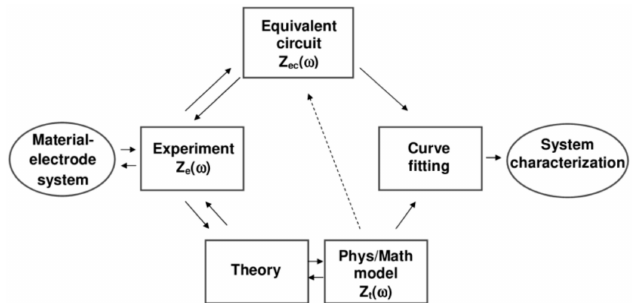
Figure 3. A scheme showing the use of electrochemical impedance spectroscopy (EIS) to investigate characteristics of a material–electrode interface. Reprinted from ref. [52], Copyright 2005, with permission from John Wiley and Sons.